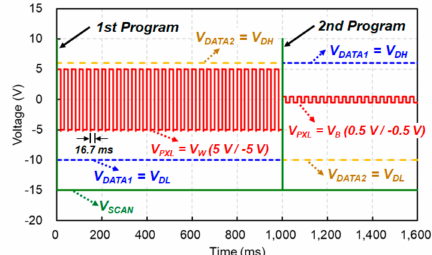
Figure 4. Simulated results to verify the programming operation of the proposed MIP